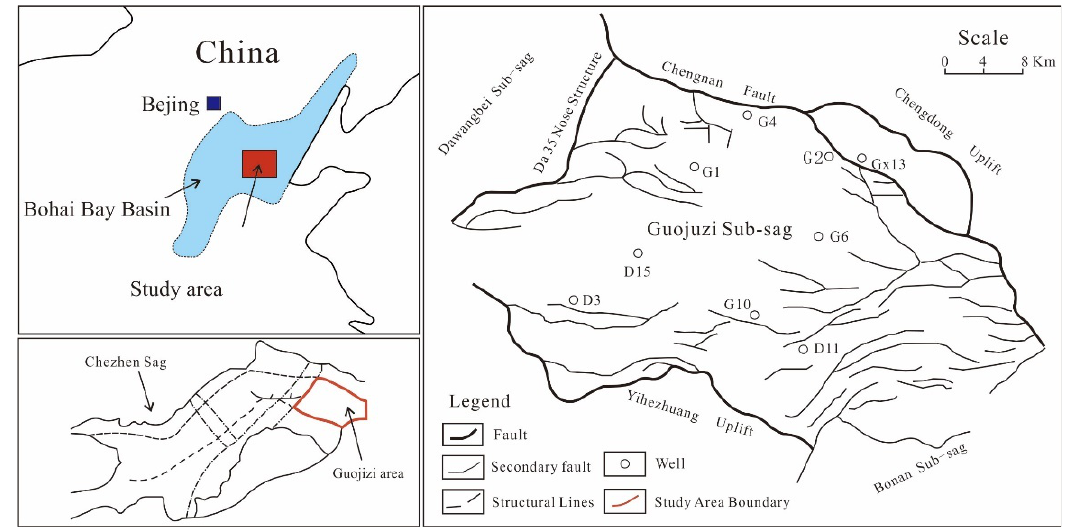
Figure 1. The geographical location and geological structure of the study area.